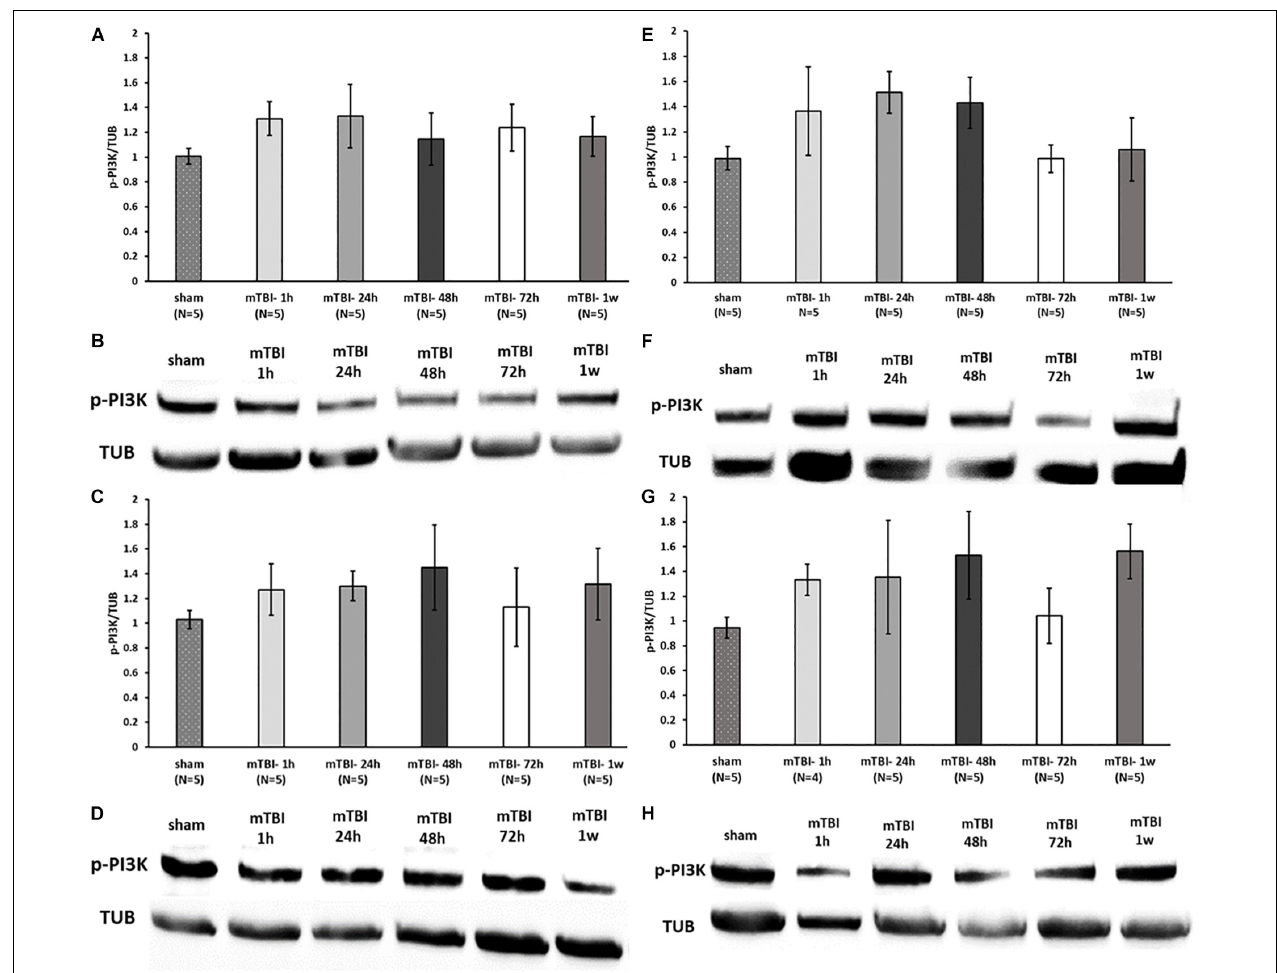
FIGURE 8 | mTBI challenge does not affect the p-PI3K levels in the cortex and hippocampus. Graphs showing p-PI3K expression in ipsilateral/right (A) and contralateral/left (C) cortex and ipsilateral (E) and contralateral (G) hippocampus in sham and 1 h to 1 week following mTBI. One-way ANOVA analysis showed no significant differences between the groups in all brain regions, indicating that mTBI induction does not affect the p-PI3K levels at the times tested [ A: F (5,24) = 0.538; NS, C: F (5,24) = 0.365; NS, E: F (5,24) = 1.236; NS, G: F (5,23) = 0.813; NS]. Values are mean ± SEM. (B,D,F,H) Representative images of gel electrophoresis followed by immunoblot analysis using antibodies against p-PI3K and α -tubulin in ipsilateral cortex, contralateral cortex, ipsilateral hippocampus, and contralateral hippocampus,